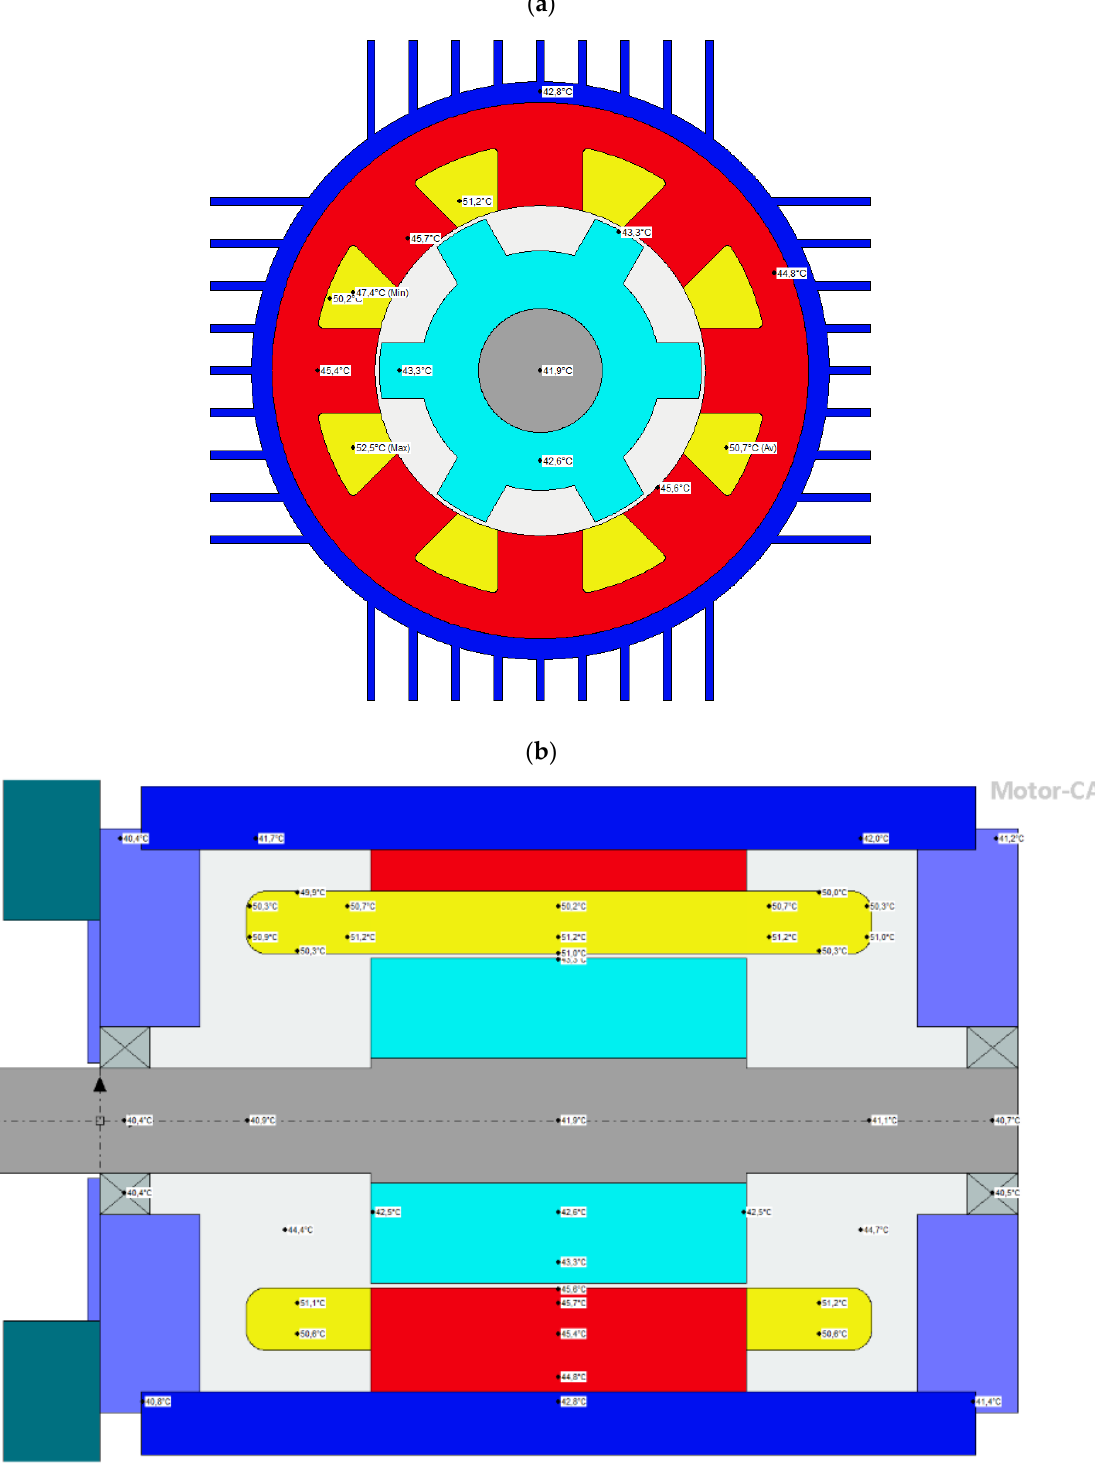
Figure 18. Thermal properties simulations of an 8/6 motor: ( a ) Temperature distribution for different regions of the motor during its operation [°C]; ( b ) Temperature distribution, motor cross-section [°C].